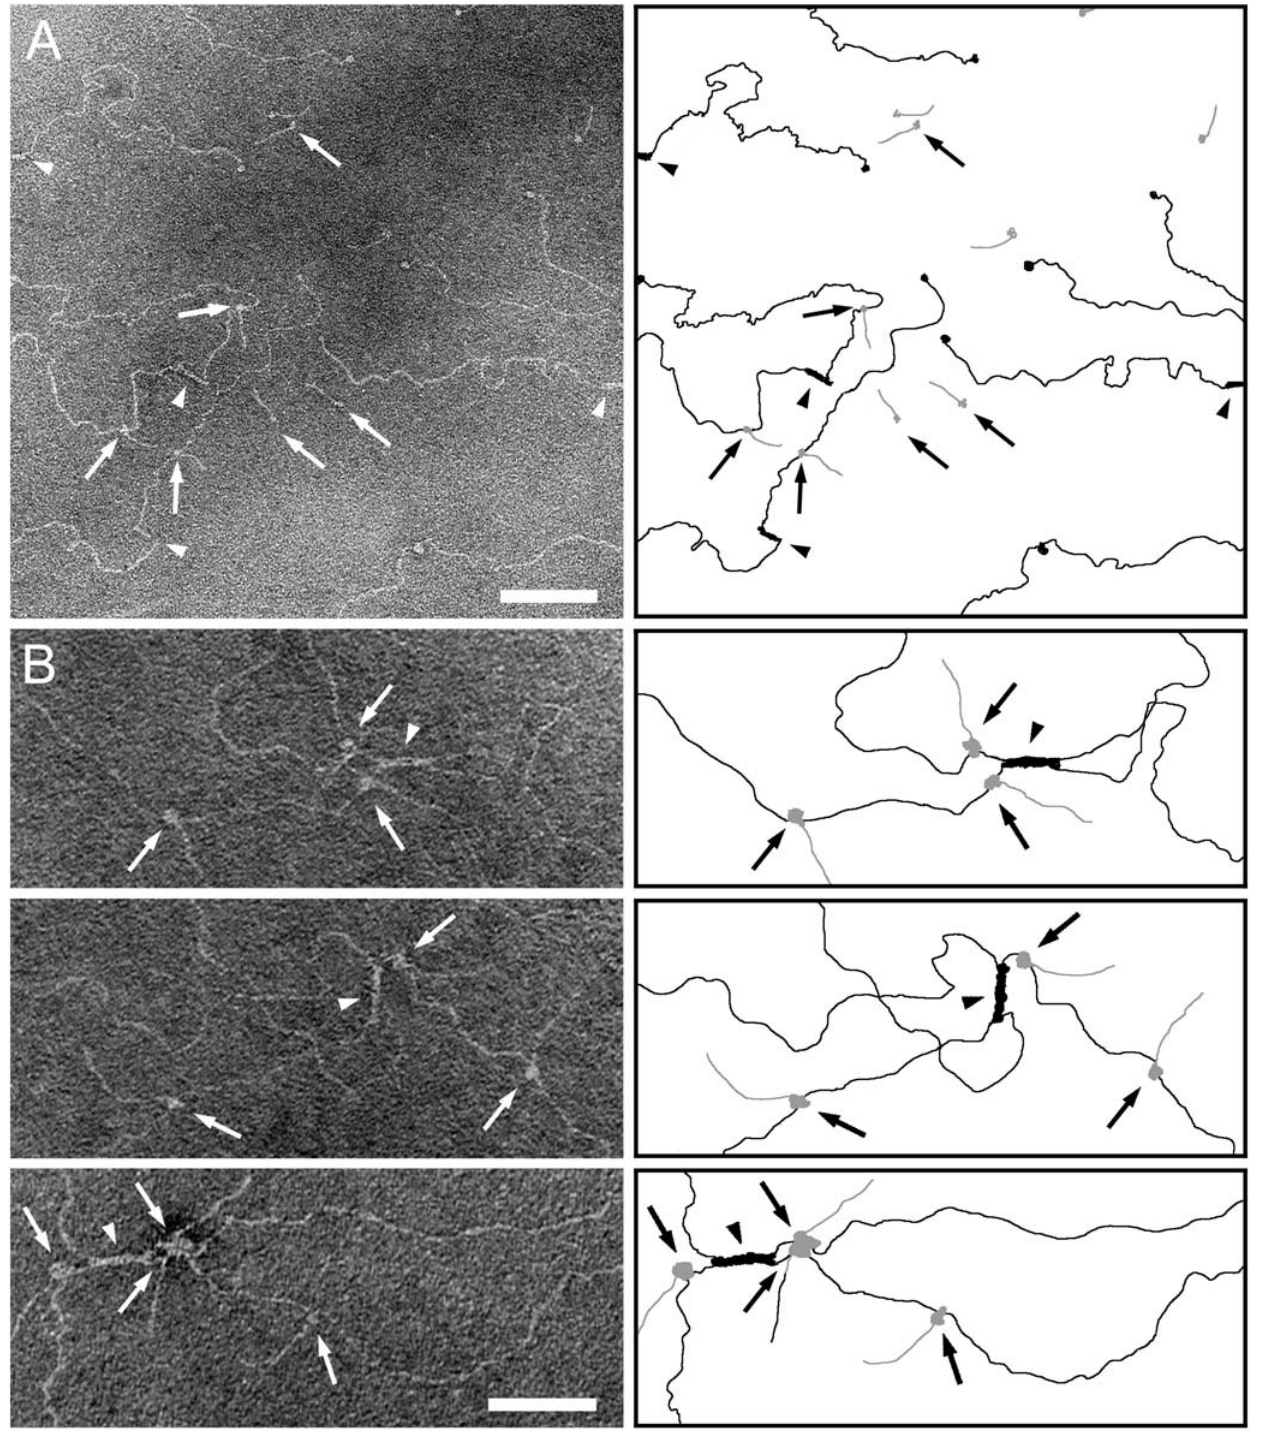
Figure 1. Electron microscopy of M3-CIV complexes. Micrographies ( left panel ) and corresponding cartoons ( right panel ) show complexes that consist of M3-protein and CIV. Block arrows highlight M3-protein (depicted in gray in the cartoons), both free and bound to CIV (depicted in black in the cartoons). Arrow heads point out the 7S regions of CIV, while line arrows points out the globular heads of the CIV molecules. The bars represent 100 nm in the representative overviev ( A ) and 50 nm in the panel of selected complexes ( B ).